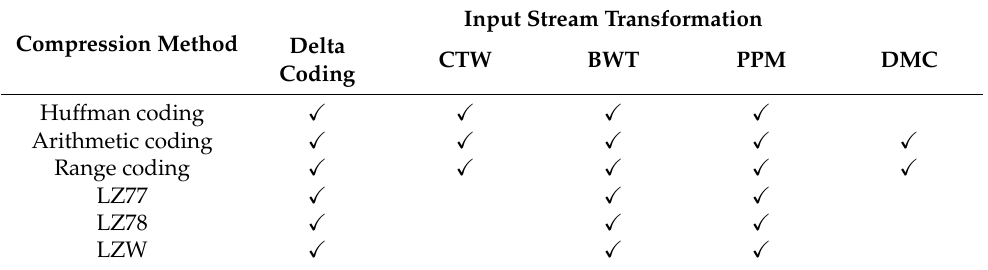
Table 5. Possible combinations of coders and transformations. Compression Method